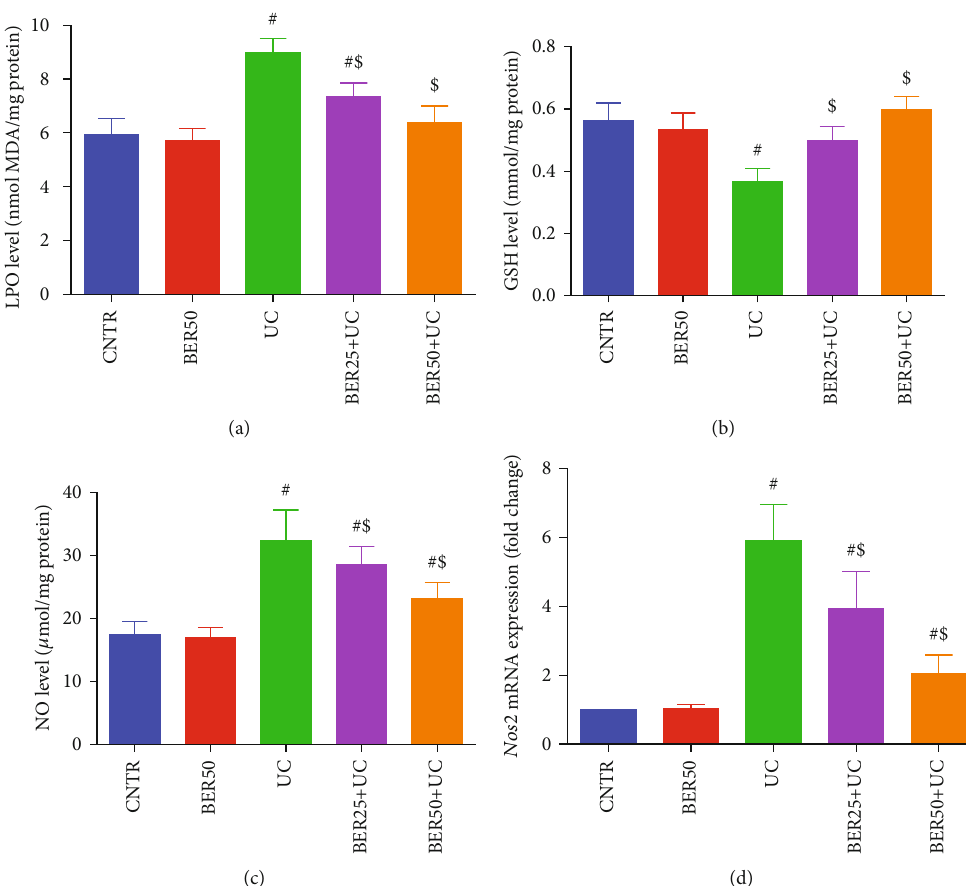
Figure 3: E ff ect of berberine at di ff erent doses on oxidative stress markers ((a) LPO, (b) GSH, and (c) NO) and (d) Nos2 mRNA expression in colonic tissue of experimental colitis in rats. The results are expressed as the mean ± SD ( n = 7 ). qRT-PCR results of Nos2 were normalized with Gapdh and represented as fold change as compared to mRNA levels in the CNTR rats. # p < 0 : 05 compared to the CNTR group (intact group); $ p < 0 : 05 compared to UC-untreated